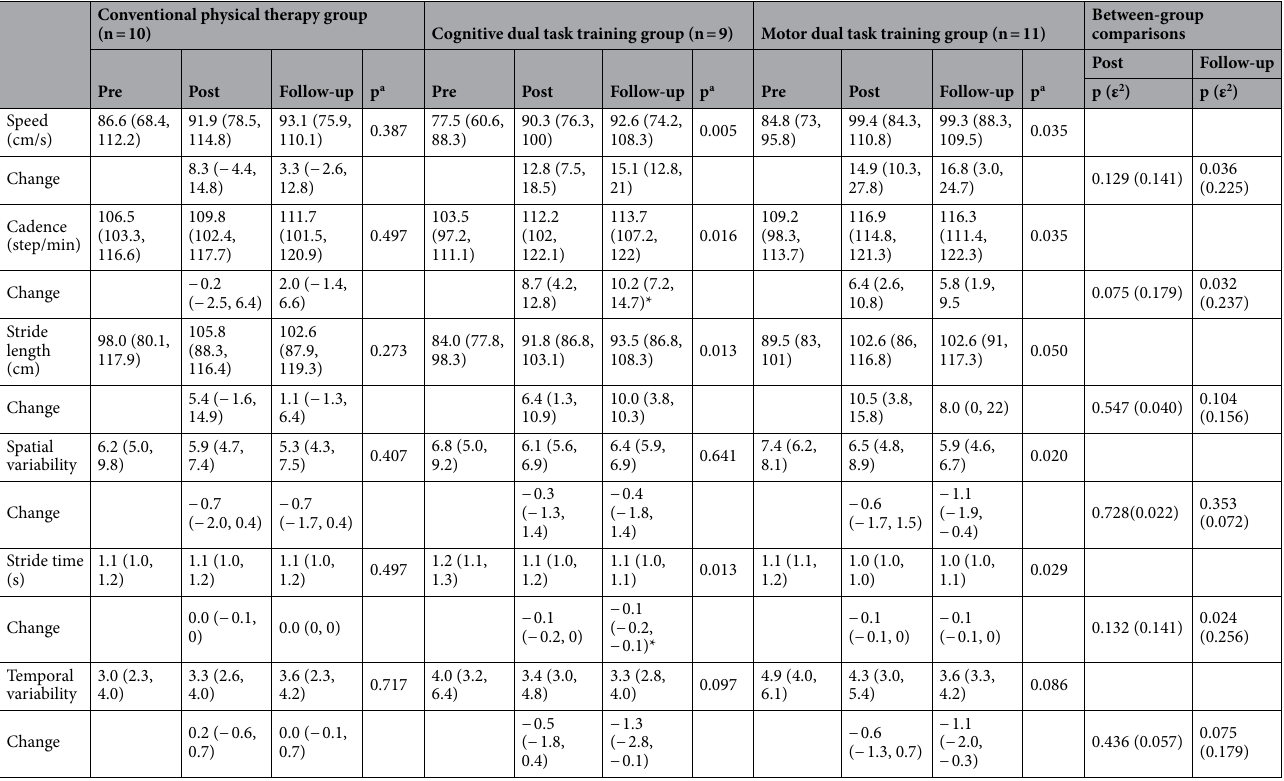
Table 4. Comparisons of single walking performance after training at different time point. Values are median (interquartile). Change values were calculated by subtracting the baseline data from the post-training data (Post) or by subtracting the baseline data from the follow-up data (Follow-up). a p value for within-group comparison using Friedman test. *p < 0.05 as compared with conventional physical therapy group.